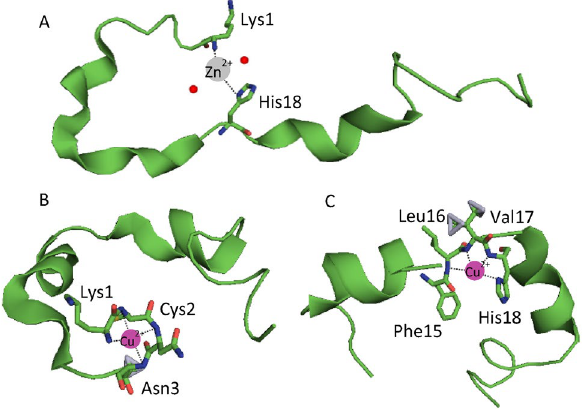
Figure 2. Established coordination modes for the ( A ) Zn(II)-pramlintide complex above pH 7.4, and Cu(II)- pramlintide complex. At pH 7.4 Cu(II) may be coordinated to either ( B ) the N-terminal amine and three neighbouring amide nitrogens or ( C ) the His18 imidazole nitrogen and three neighbouring amide nitrogens. The structures are based on a Phyre2 simulation 33 and the figure was generated by PyMOL 34 .